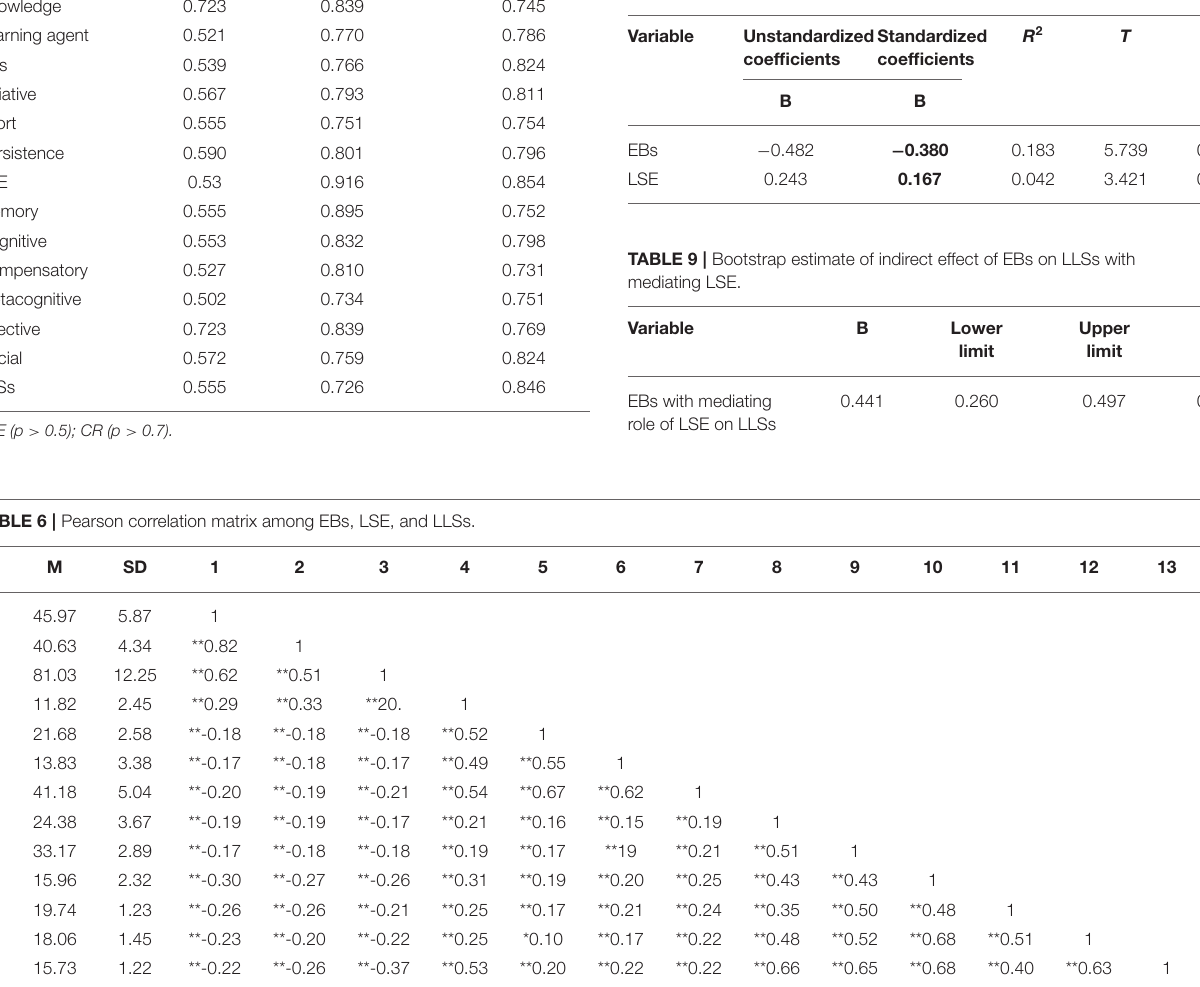
TABLE 8 | Direct maximum likelihood estimation for LLSs.